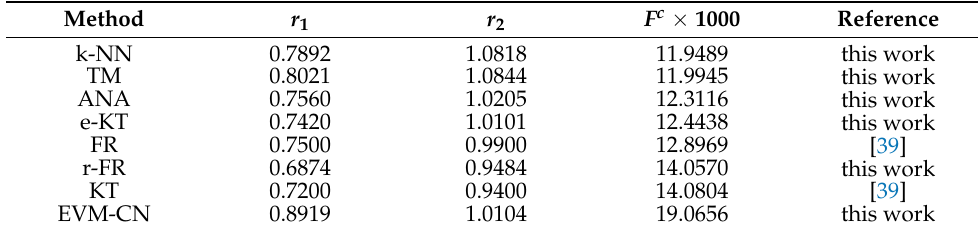
Table 22. The reactivity ratios obtained for copolymerization of Is-GMA